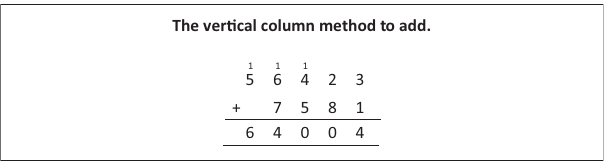
FIGURE 10: An example of SWA to solve 34 + 27 = … in the Foundation Phase exemplars of the TMU framework.